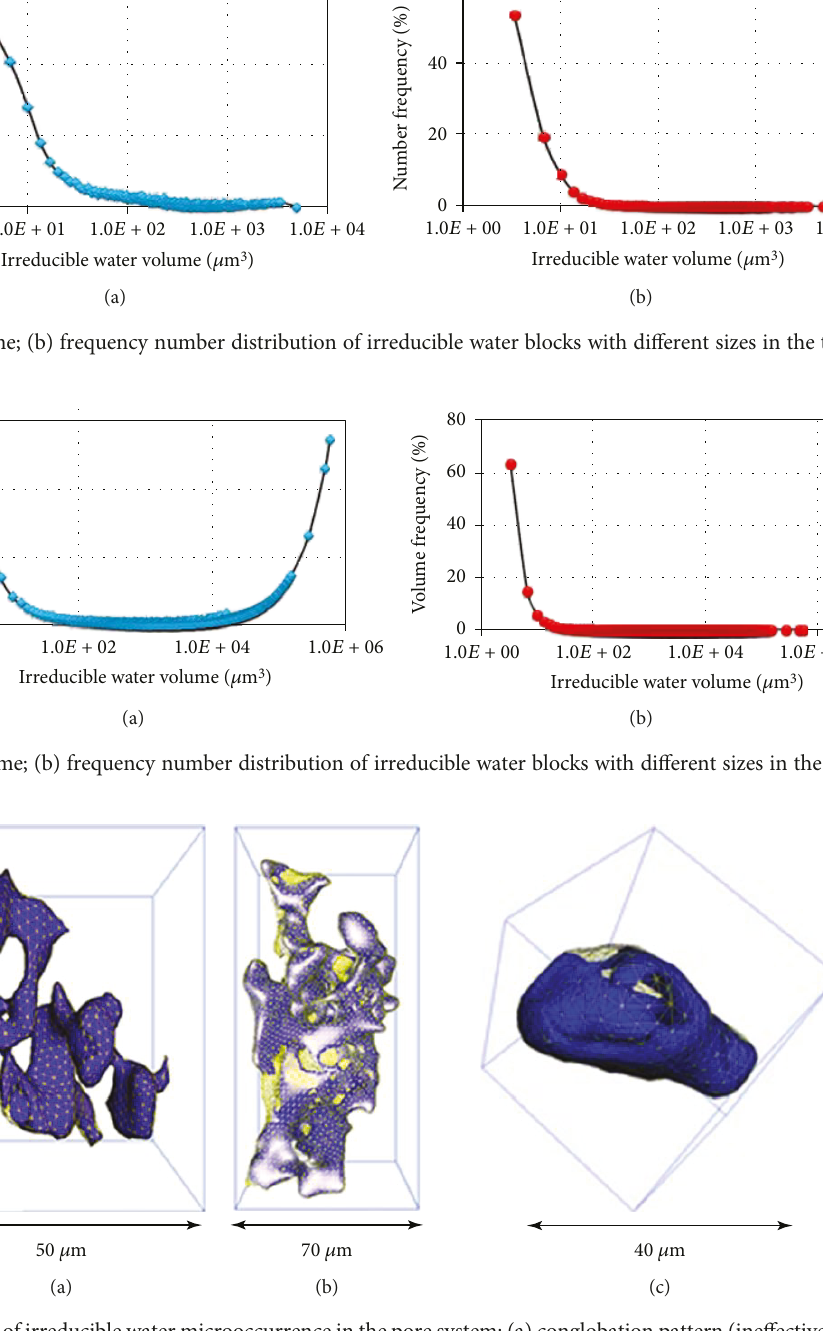
Figure 16: Di ff erent modes of irreducible water microoccurrence in the pore system: (a) conglobation pattern (ine ff ective oil reservoir space); (b) cluster pattern (partially e ff ective oil reservoir space); (c) water- fi lm pattern (e ff ective oil reservoir space). Note: the yellow area represents a given pore or throat surface and the blue area represents irreducible